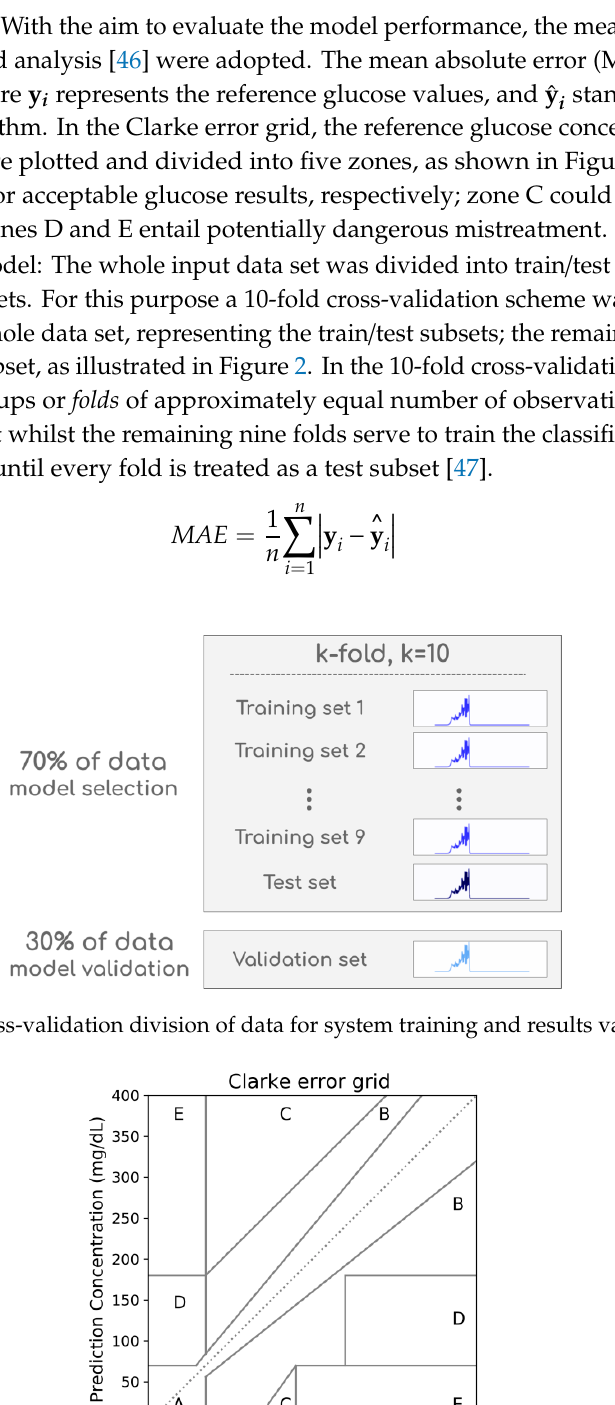
Figure 3. Cross-validation division of data for system training and results validation. 2.5.2. System Implementation The whole system was implemented using a Flask server, which allows performing multiple functions or microservices, through a variety of API calls, and it is structured. This server is running on Windows operating system with 8 GB RAM, Core i7 processor, SSD 240 GB, Python 3.5, Flask 1.02 and MariaDB 10.1.35. Its structure is designed so that it contains the GET and POST interaction methods. The API structure for the present monitoring system is shown in Table 1, and the main functions implemented on this system, are explained in detail below.